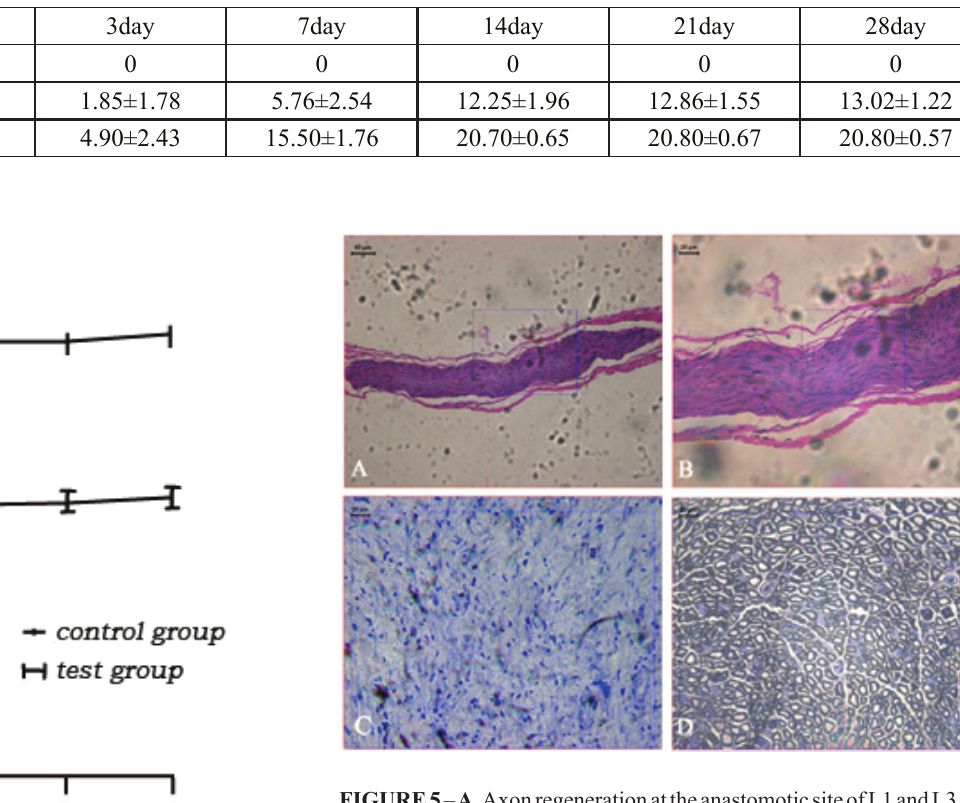
FIGURE 5 – A. Axon regeneration at the anastomotic site of L1 and L3 (HE staining; magnification: ×20; longitudinal section). B. Axon regeneration